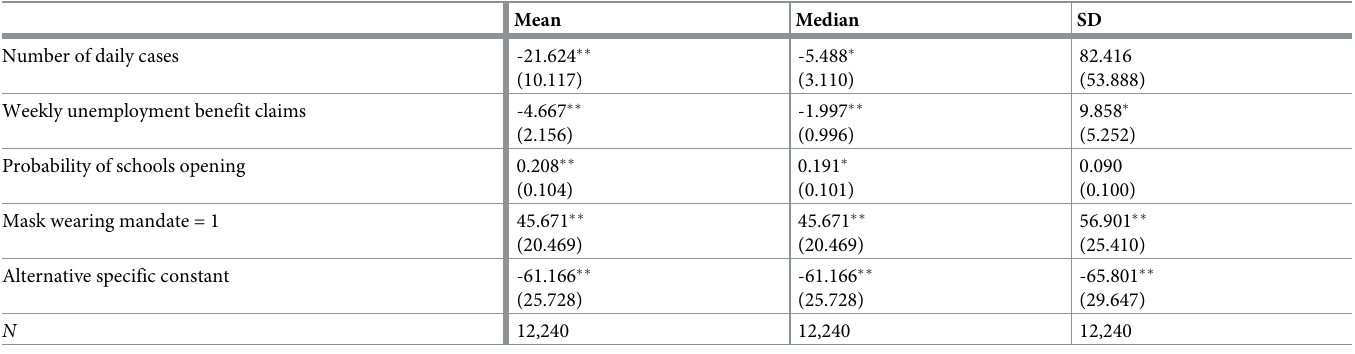
Table 3. Estimated WTS for different attributes in the WTS